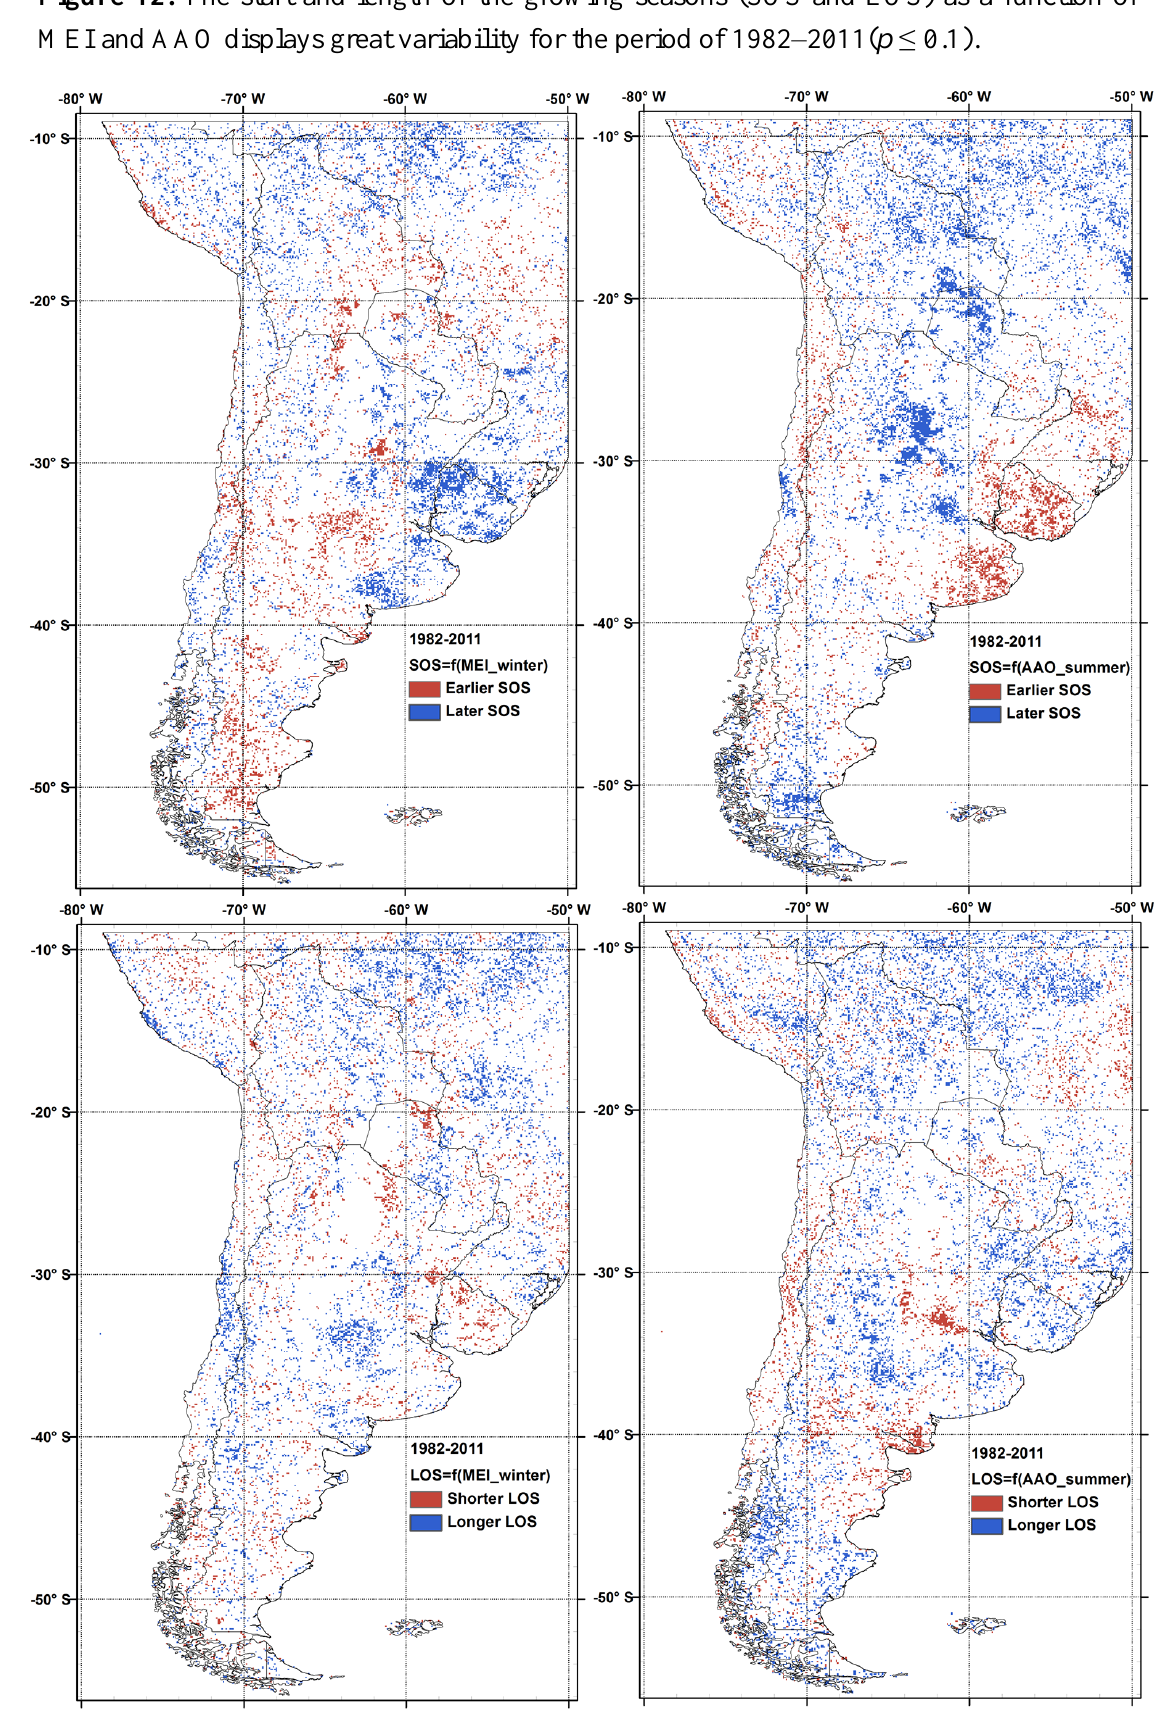
Figure 12. The start and length of the growing seasons (SOS and LOS) as a function of MEI and AAO displays great variability for the period of 1982–2011( p ≤